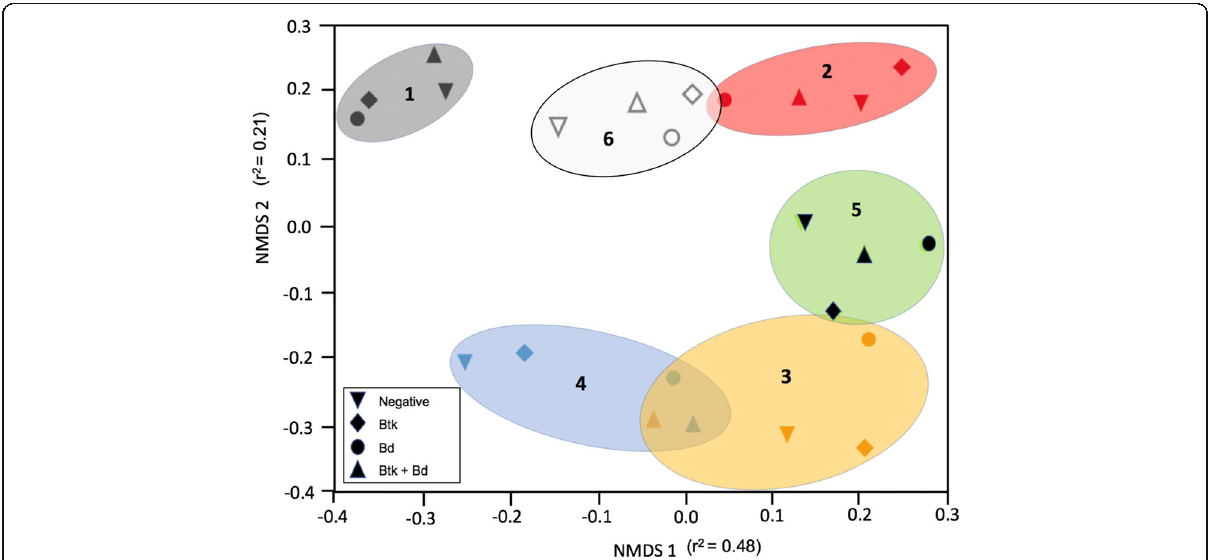
Fig. 3 Within-treatment variation in microbial communities over sampling time. Non-metric Multidimensional Scaling (NMDS) ordination using Bray-Curtis dissimilarity distances. Each symbol represents an average of the Bray-Curtis value for each treatment group. Ellipses group sampling time together and include a label to indicate the sampling period. 4D stress =